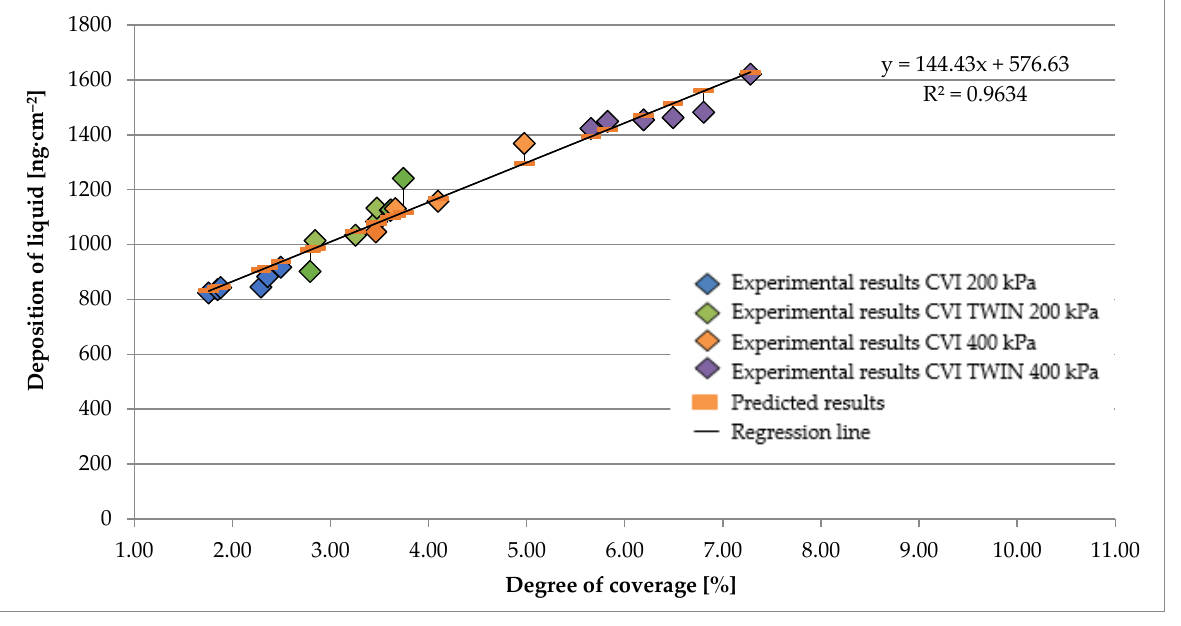
Figure 9. The scatter plot of the degree of coverage and deposition of spray liquid for selected air-induction nozzles for leaving the vertical surface.